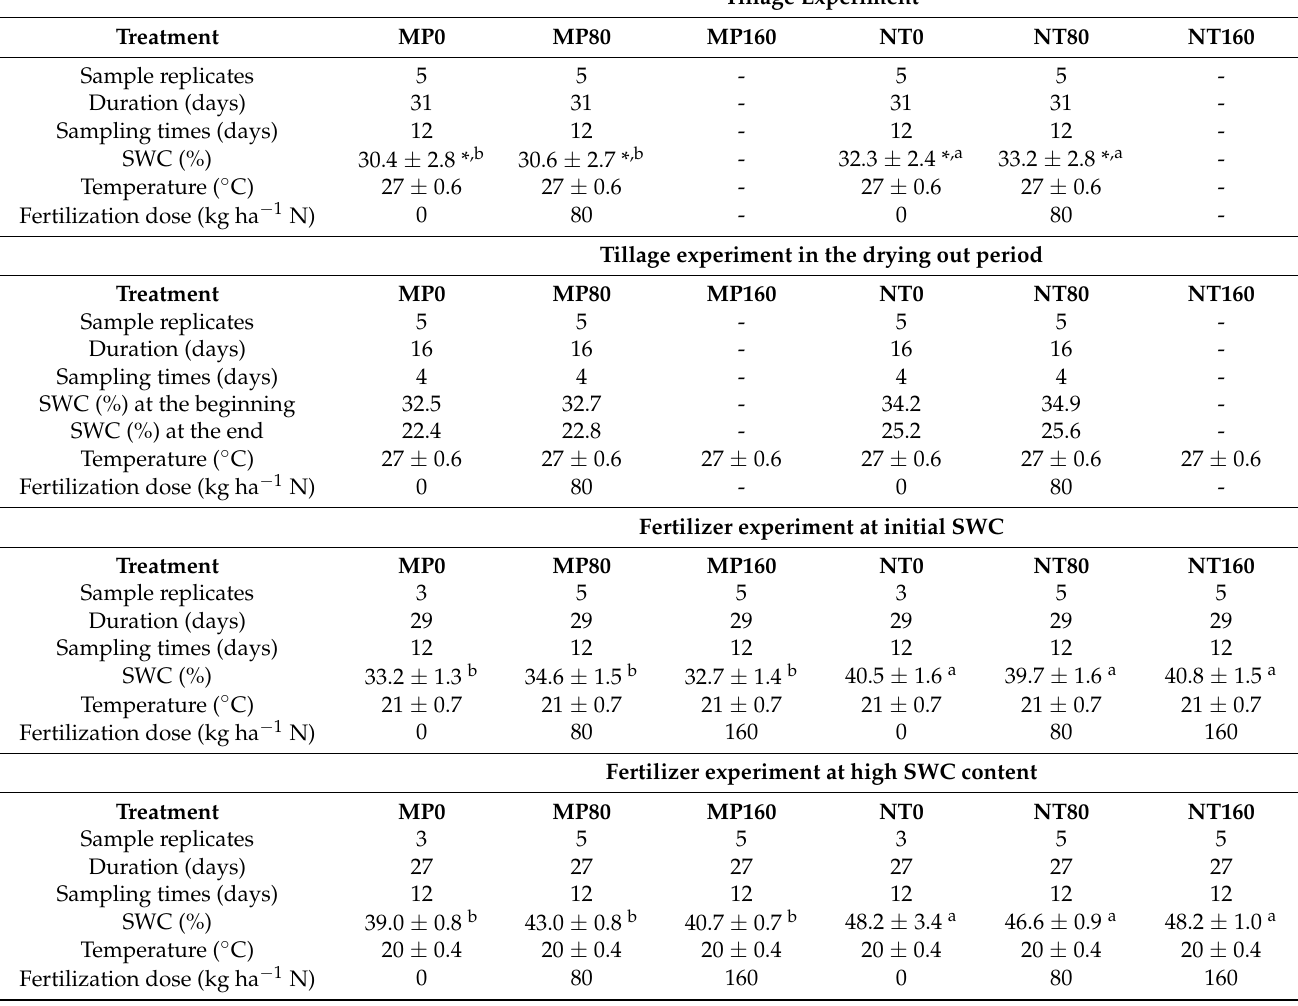
Table 2. Details of the Tillage and Fertilizer soil column experiments. Tillage